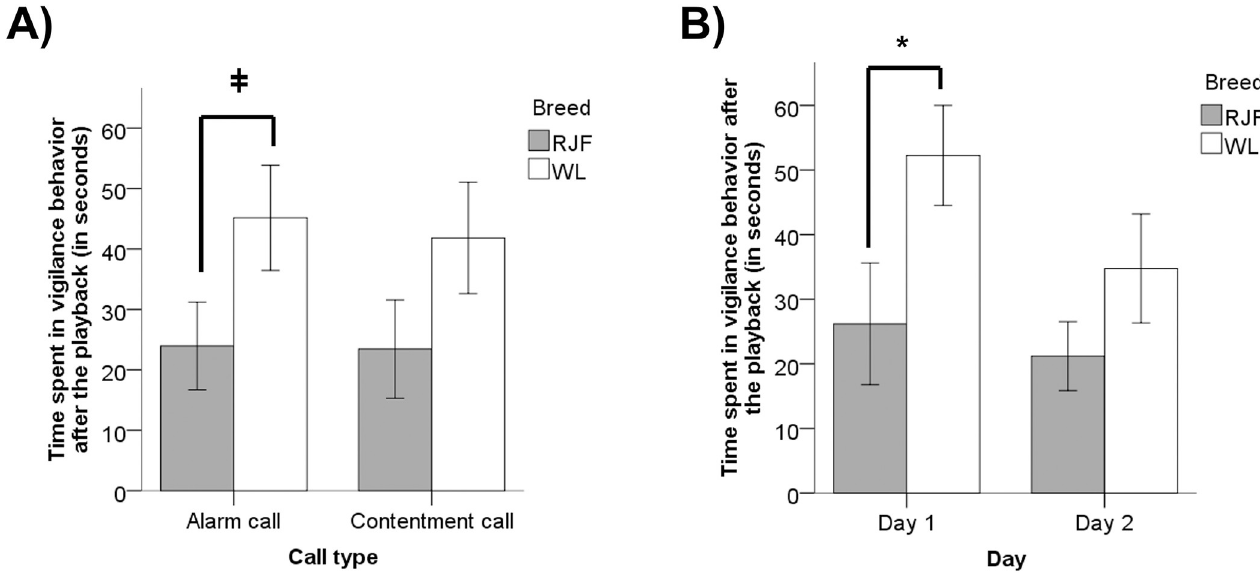
Fig 2. Time spent in vigilance behavior (in seconds) for White Leghorn (WL) and Red Junglefowl (RJF) hens, A) after the playbacks of contentment and alarm calls, and B) after the playbacks and over testing days (Day 1 and 2, without taking into account the playback call type). Mean ± SD are given. (n WL = 6 pairs, n RJF = 8